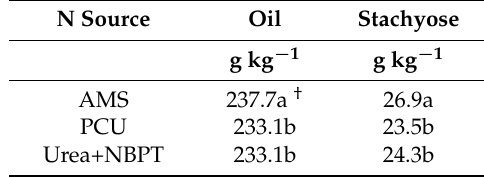
Table 4. Soybean seed oil and stachyose sugar concentration as affected by the N sources on silt-loam soil in 2015. N